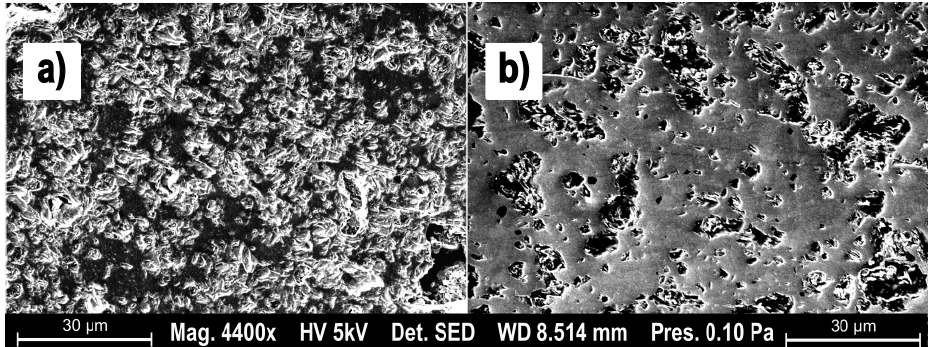
Figure 7. SEM micrographs showing two surfaces: ( a ) brittle material removal; ( b ) ductile material removal.